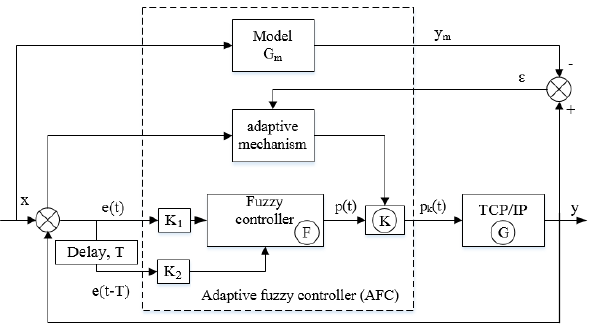
Figure 2. Improved model AQM mechanism by AFC